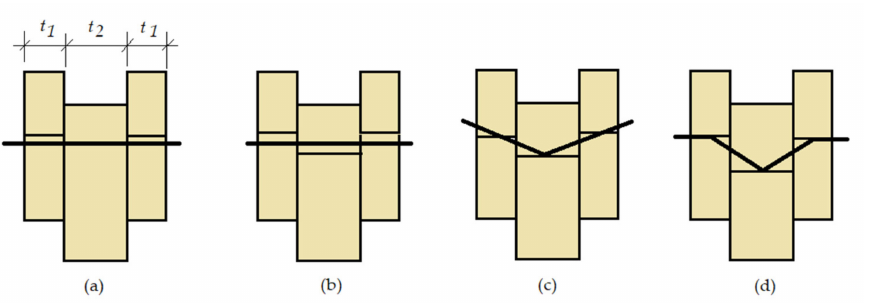
Figure 1. Steel-to-timber connections in double shear (W-S-W): ( a ) wood embedding; ( b ) fastener bending; ( c ) combination of failure modes.